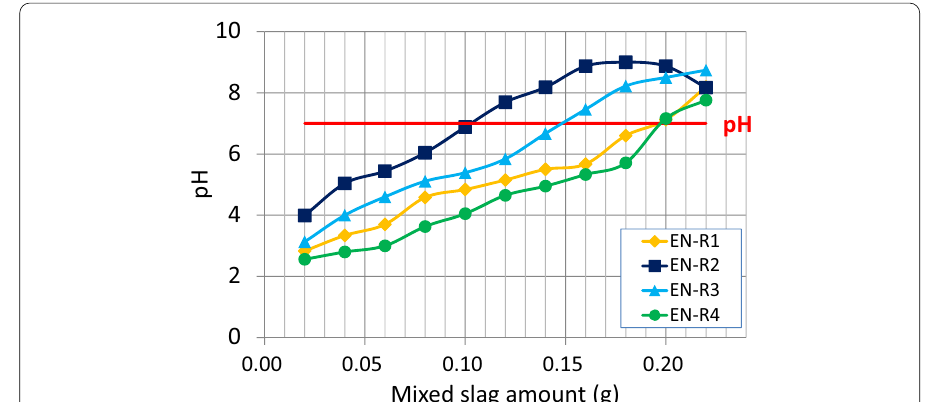
Fig. 1 pH change of Pohang Tertiary mudstone samples according to the addition of mixed slag